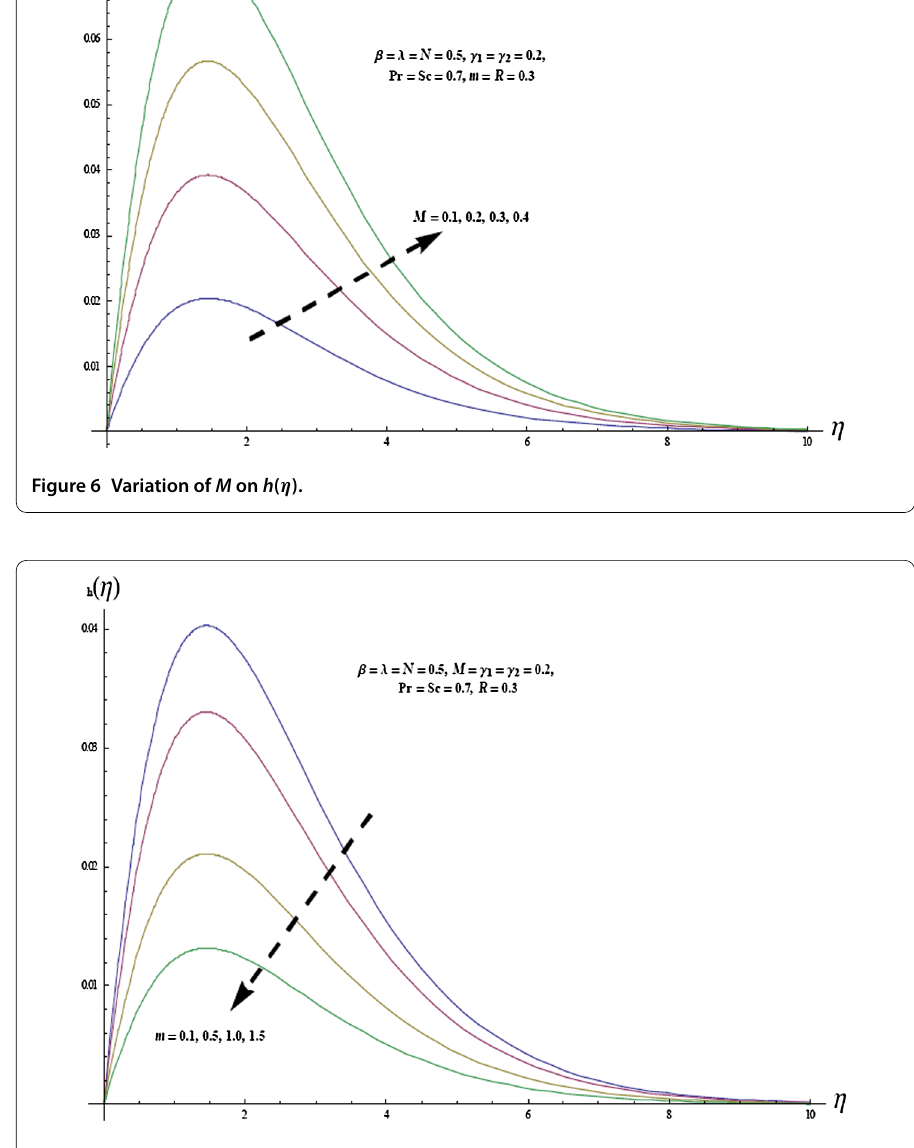
Figure 7 Variation of m on h ( η